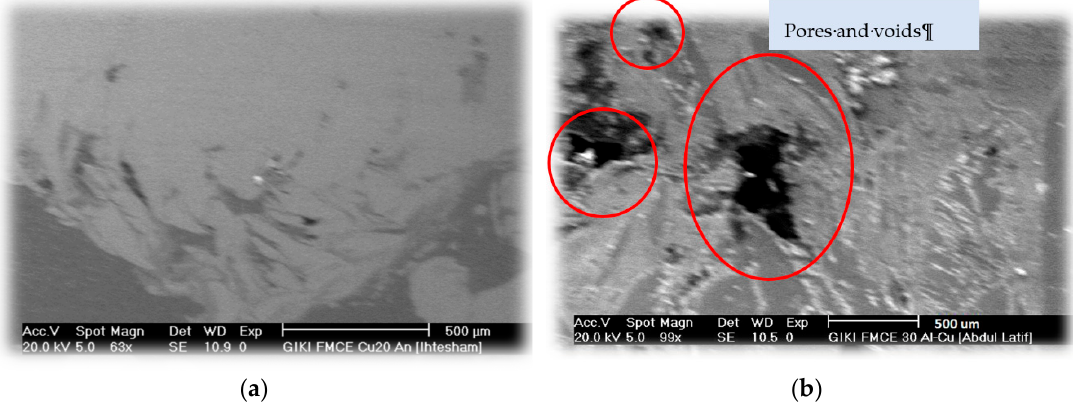
Figure 10. Scanning electron microscopy of 2219Al-Cu lap joint at F 30.0 mm/min using ( a ): WC tool, ( b ) HSCo square- tool. Table 7. Comparison of joint strength between dissimilar lap joints fabricated with WC and HSCo- steel tools.